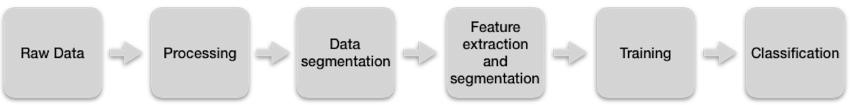
Figure 2. Activity recognition workflow (we adapted it from Bulling et al.